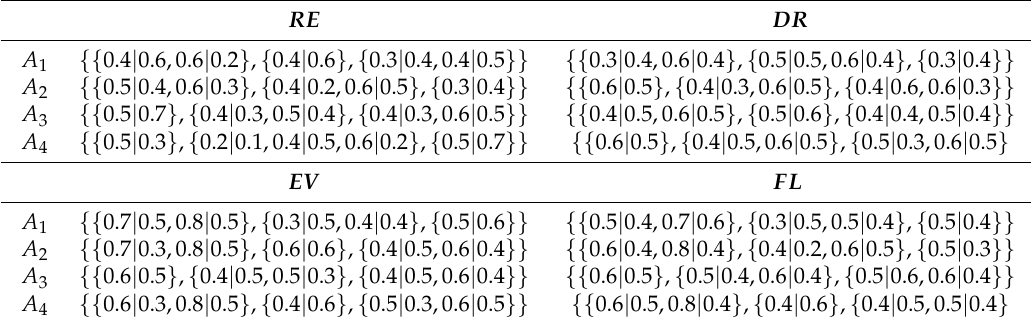
Table 4. Probabilistic neutrosophic hesitant fuzzy decision matrix of E 1 .